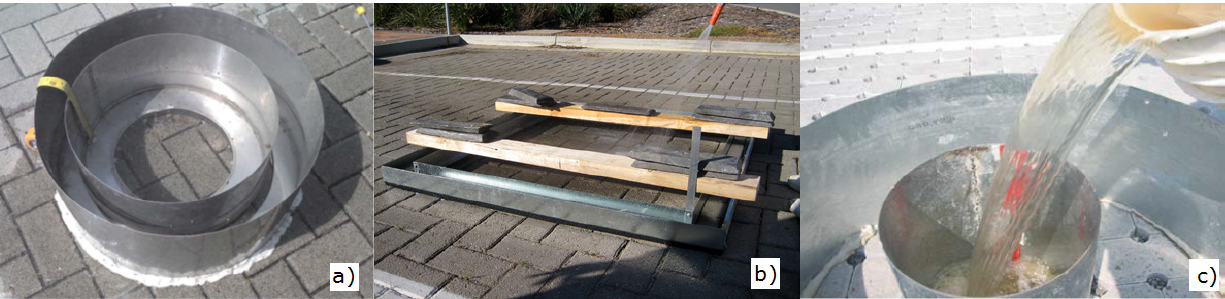
Figure 3. Modified ring infiltrometers used for permeable pavement testing: ( a ) double-ring infiltrometer tests (DRIT) [15]; ( b ) square, double-ring [13]; ( c ) single-ring surface inundation test